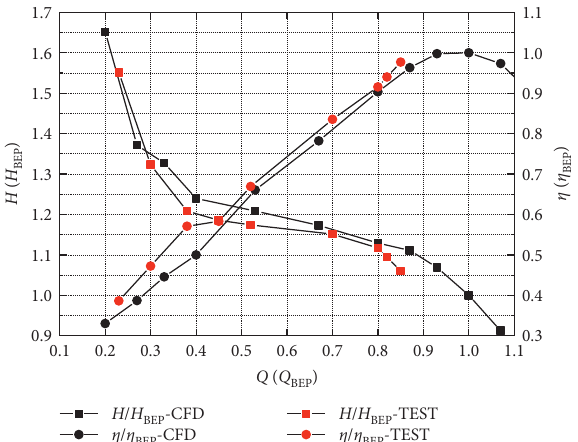
Figure 8: Efficiency of CFD and experimental results (BEP is an abbreviation for best-efficiency point. Q efficiency point. H BEP is the head at the best-efficiency point. η BEP is the efficiency at the best-efficiency point.).